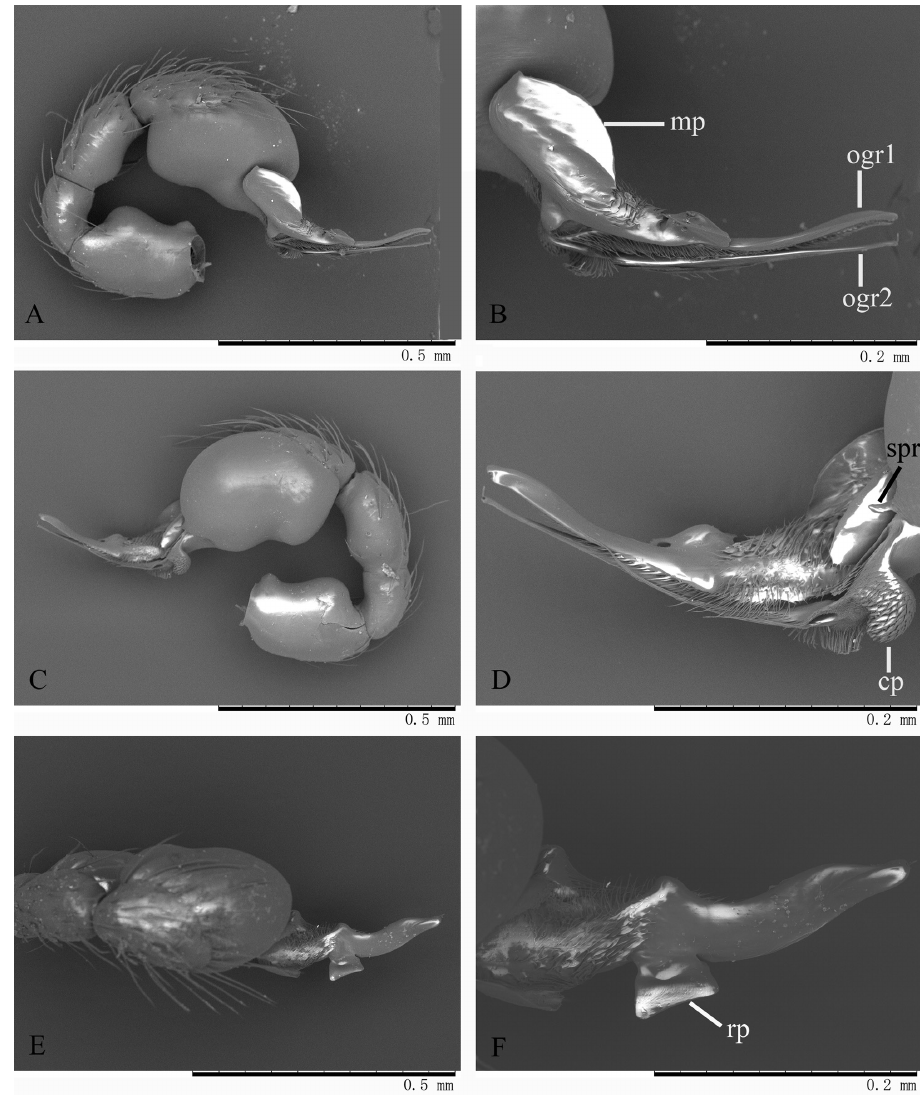
Figure 3. Trilacuna simianshan sp. n., male, SEM. A left palp, prolateral view B embolus system, pro- lateral view C left palp, retrolateral view D embolus system, retrolateral view E left palp, dorsal view F embolus system, dorsal view. Abbreviations: cp = circular projection; mp = membranous projection; ogr1 = outgrowth 1; ogr2 = outgrowth 2; rp = rectangular projection; spr = small projection.